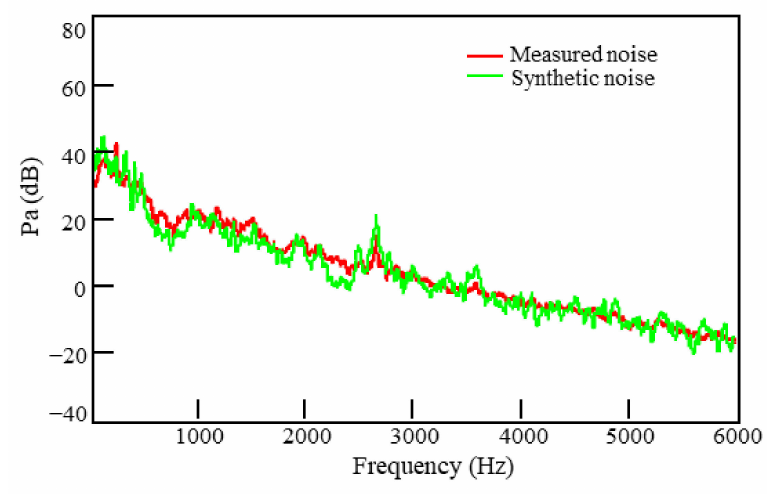
Figure 20. Comparison of synthetic and measured noise spectra in the vehicle operated at a constant speed (50 km/h).